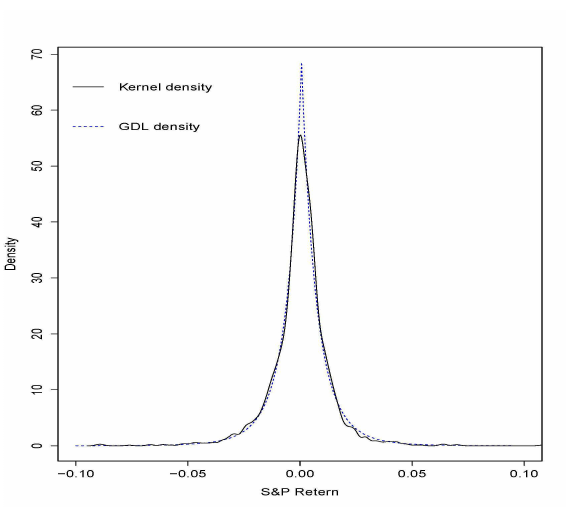
Figure 2 –: Kernel and fitted GDL densities of SP500. Estimated Kernel density (solid) of the daily returns on the SP 500 index compared with GDL density using MLE (dashed) .